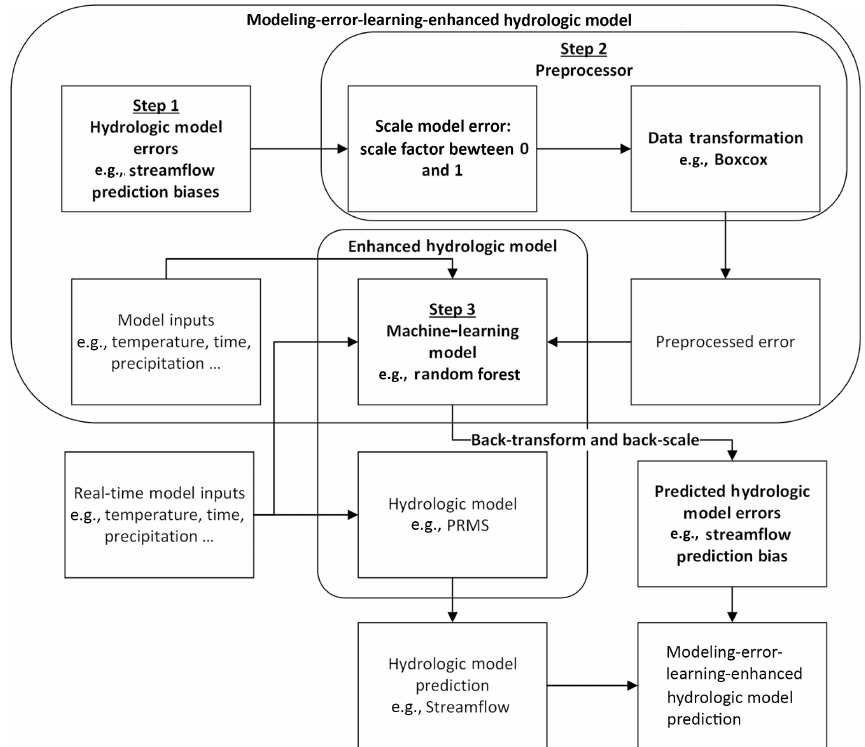
Figure 5. Modeling-error-learning-enhanced hydrologic